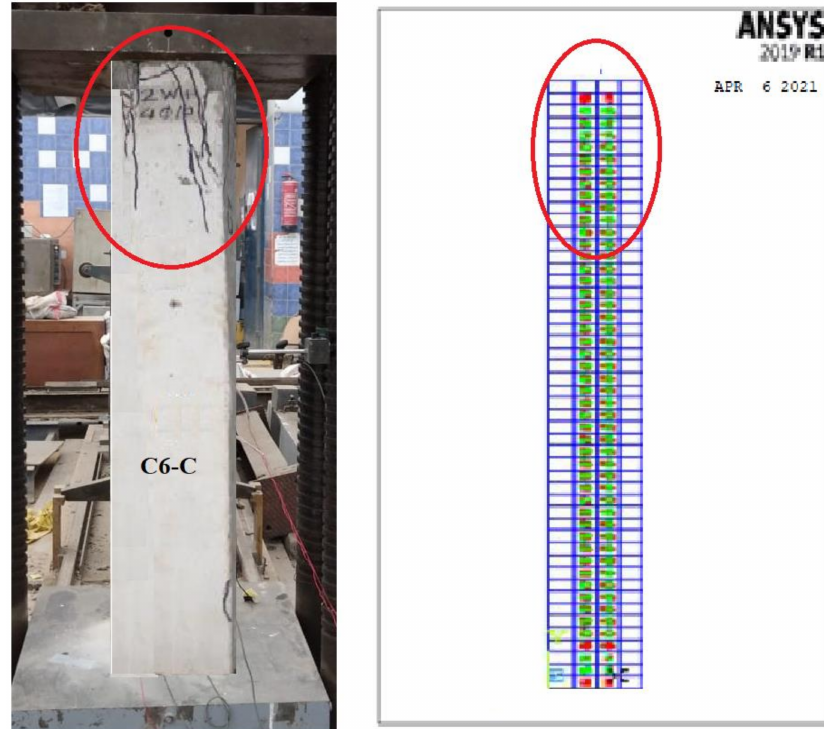
Figure 31. Cracks spread for the C6-C